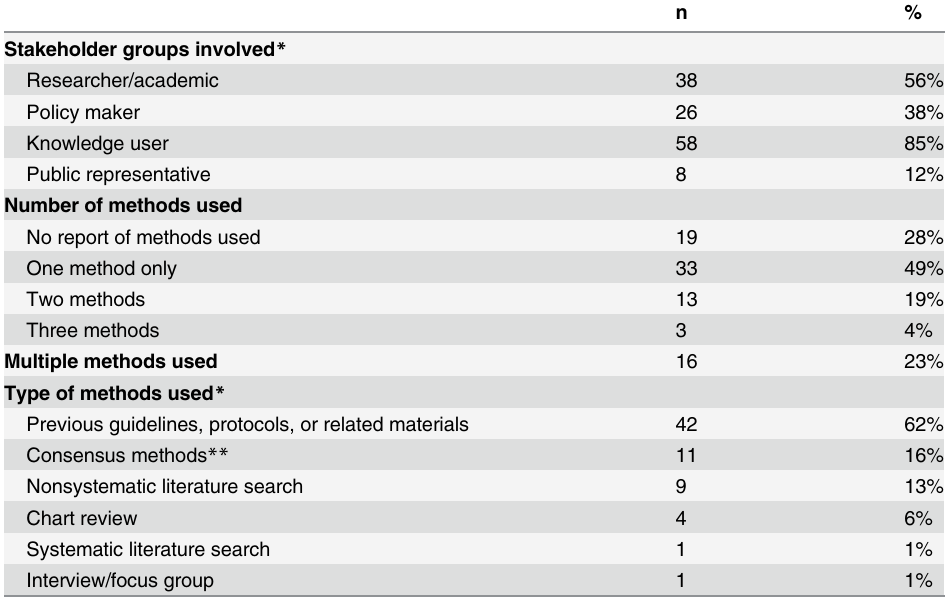
Table 2. Development of the Responses to Elder Abuse.